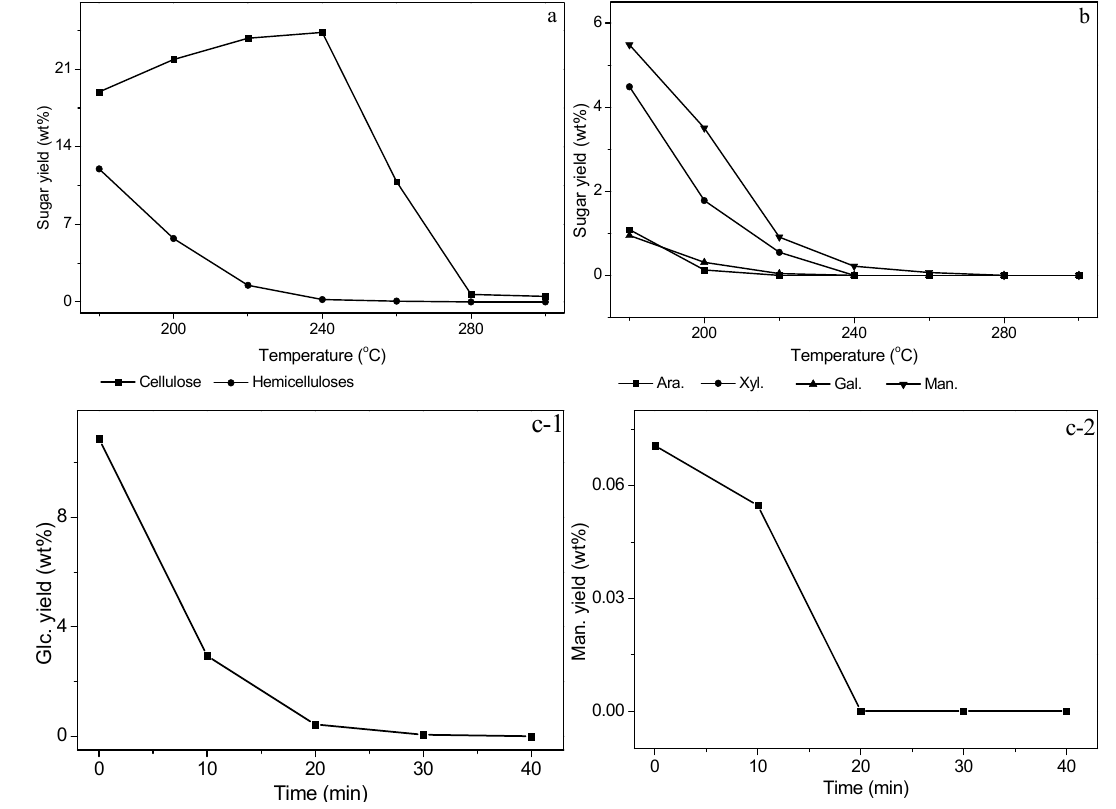
Figure 4. Sugar analysis of solid residues: ( a ) Effect of temperature on the yields of cellulose and hemicelluloses; ( b ) Effect of temperature on the yields of sugar; and ( c ) Effect of retention time on the yields of